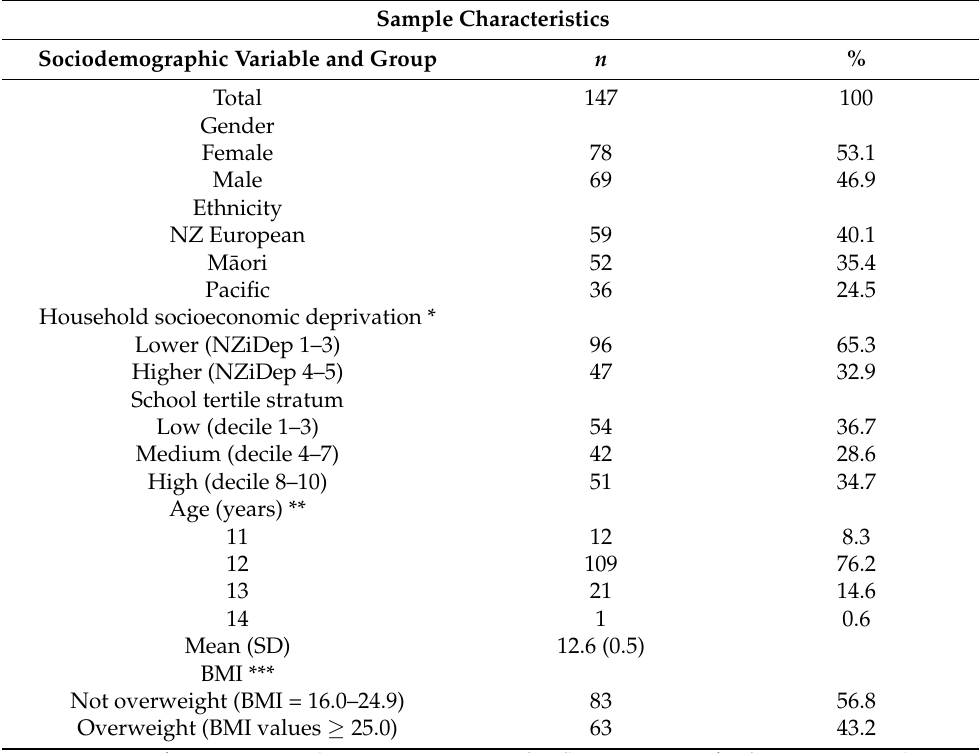
Table 1. Demographic characteristics of the sample.